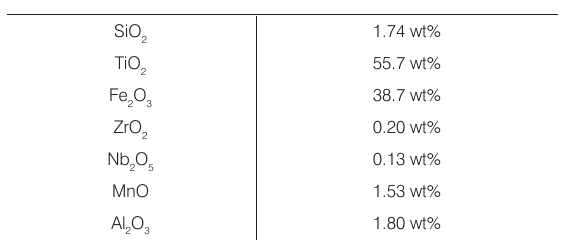
Table 1. Semi-quantitative chemical analysis of natural Brasilian ilmenite